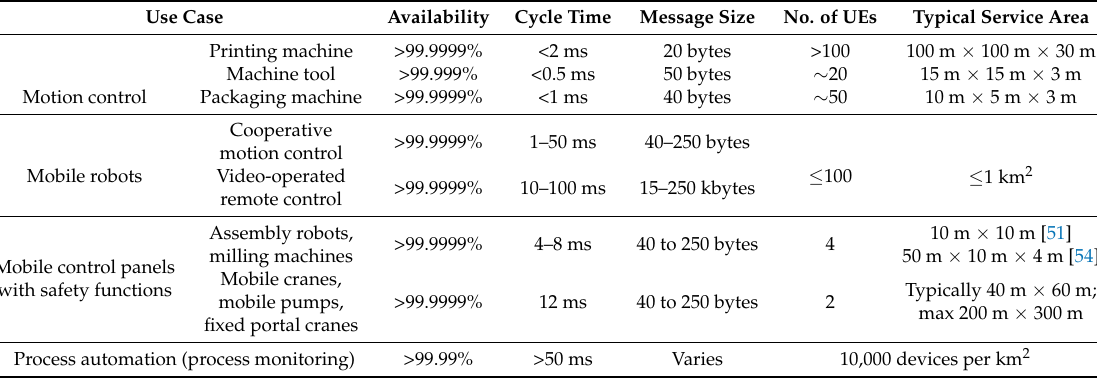
Table 2. Three application scenarios and their requirements as defined in 3GPP TR 22.804 [51] and ETSI TS 122 104 [54]. Reprinted with permission from 3GPP™, ©